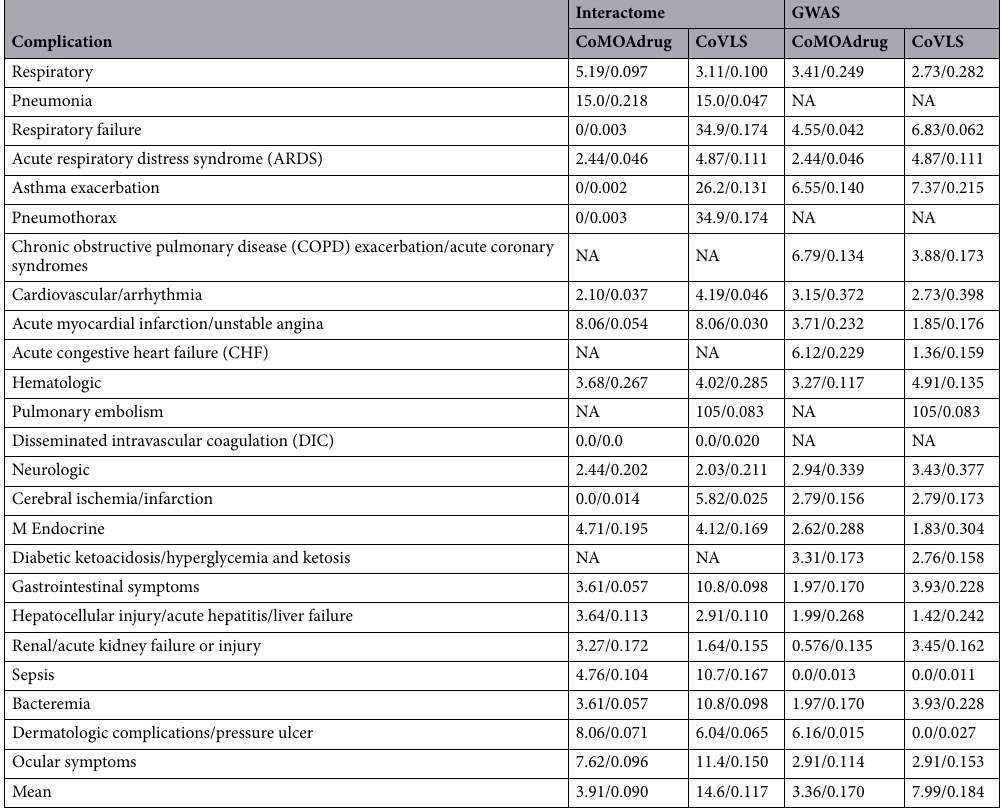
Table 5. Enrichment factor within top 20 and AUPRC of predicted drugs to treat COVID-19 complications. The first number is the enrichment factor and the second is the AUPRC.